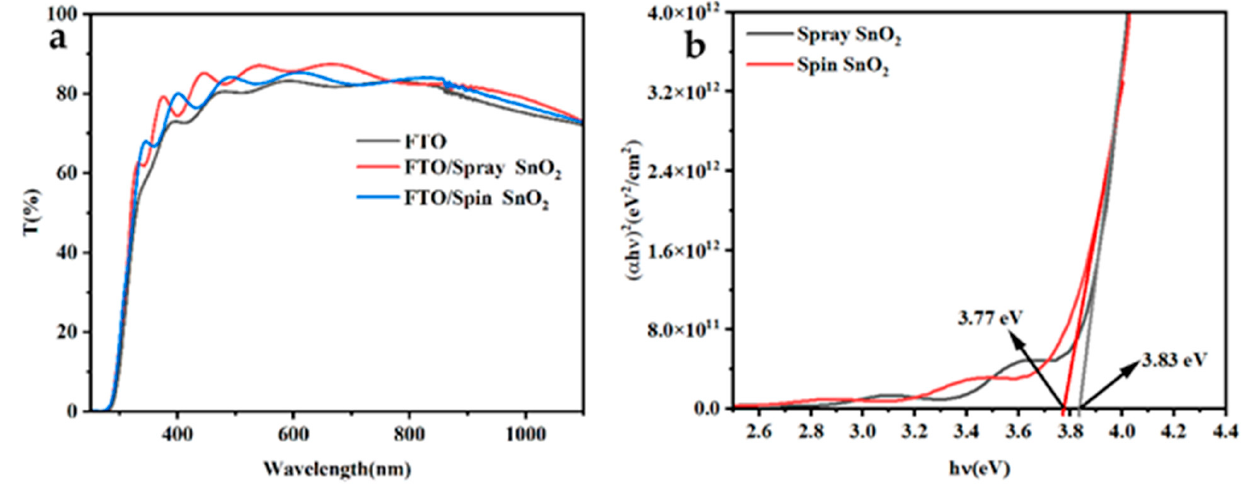
Figure 1. Transmission spectrum ( a ) and Tauc diagram ( b ) of spin-coated and sprayed SnO 2 films.